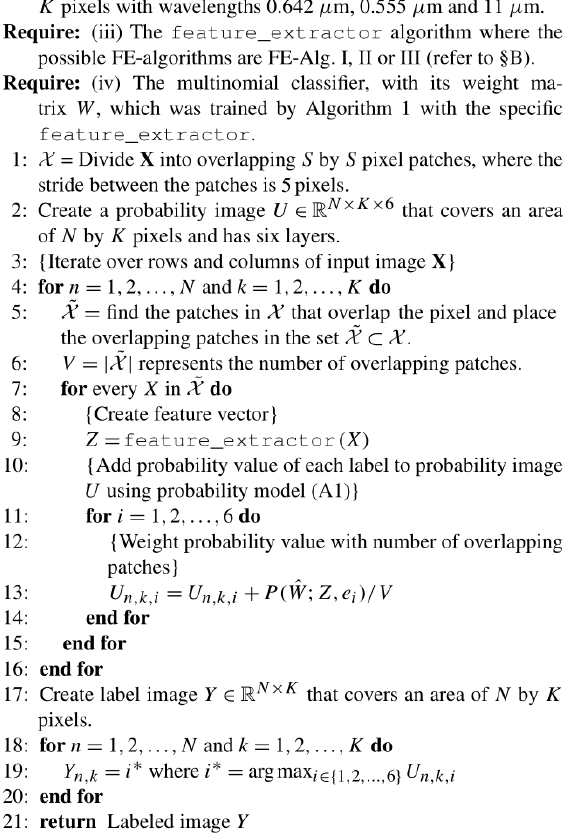
Algorithm 1 assumes that the parameters of the CNN FE algorithm are already estimated. Hence, the parameters of the fine-tuned CNN are estimated separately from Algorithm 1 with the same training dataset that is used by Algorithm